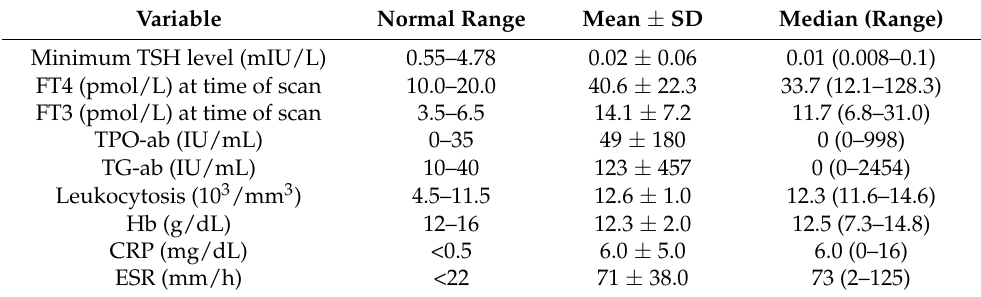
Table 1. Initial Laboratory results for SAT patients during active thyrotoxic phase ( n = 38).